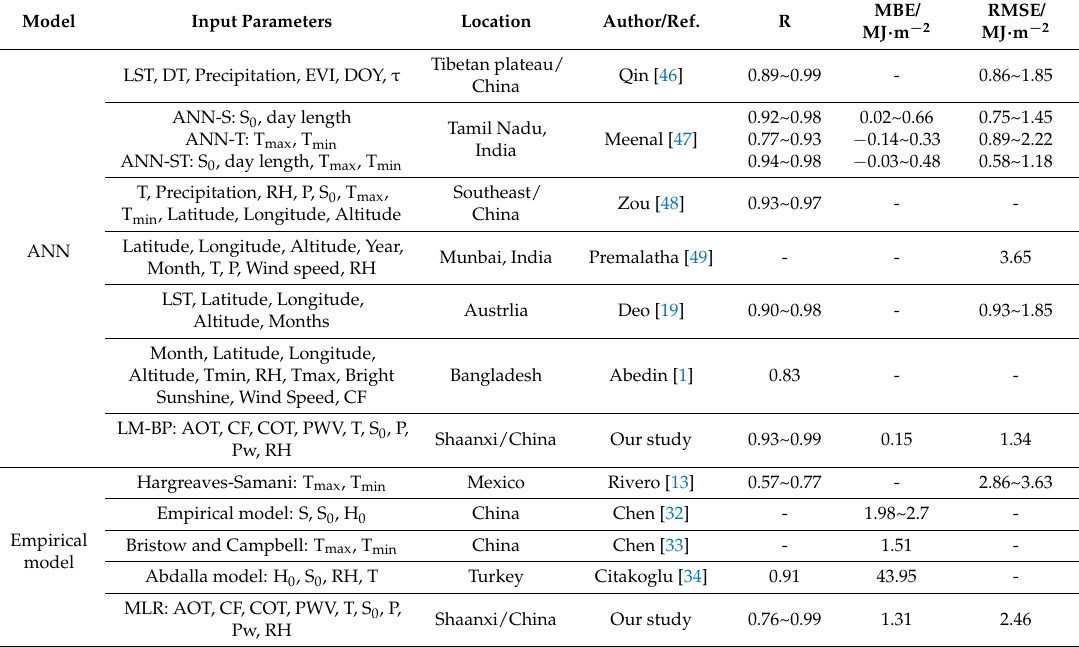
Table 4. Comparison between various monthly mean daily global solar radiation models.